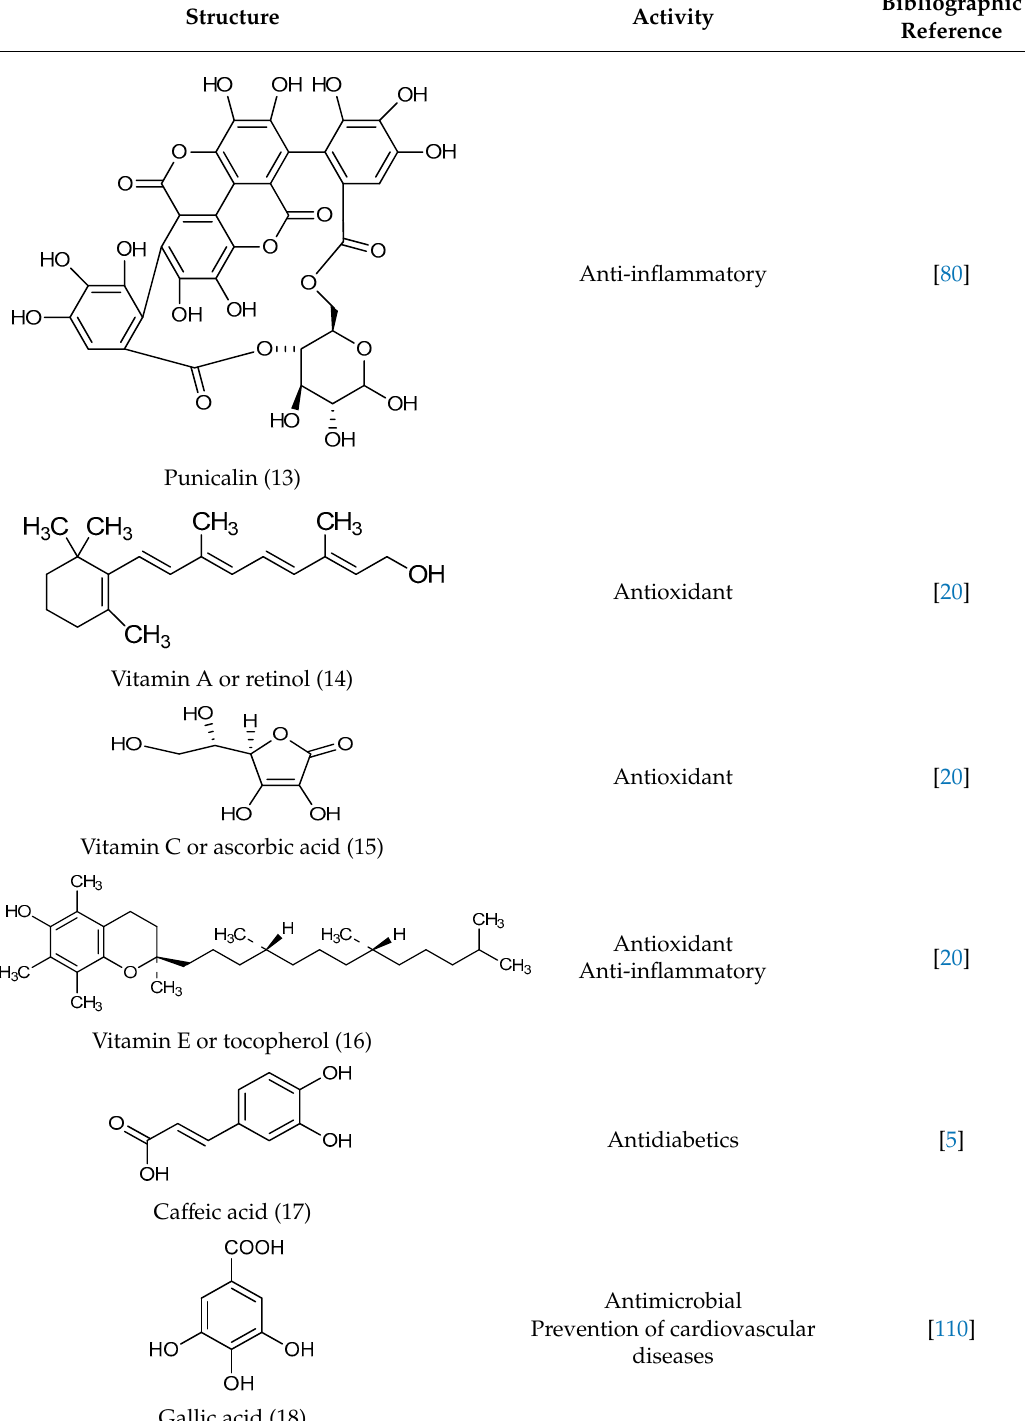
Table 2. Biological properties of different pomegranate